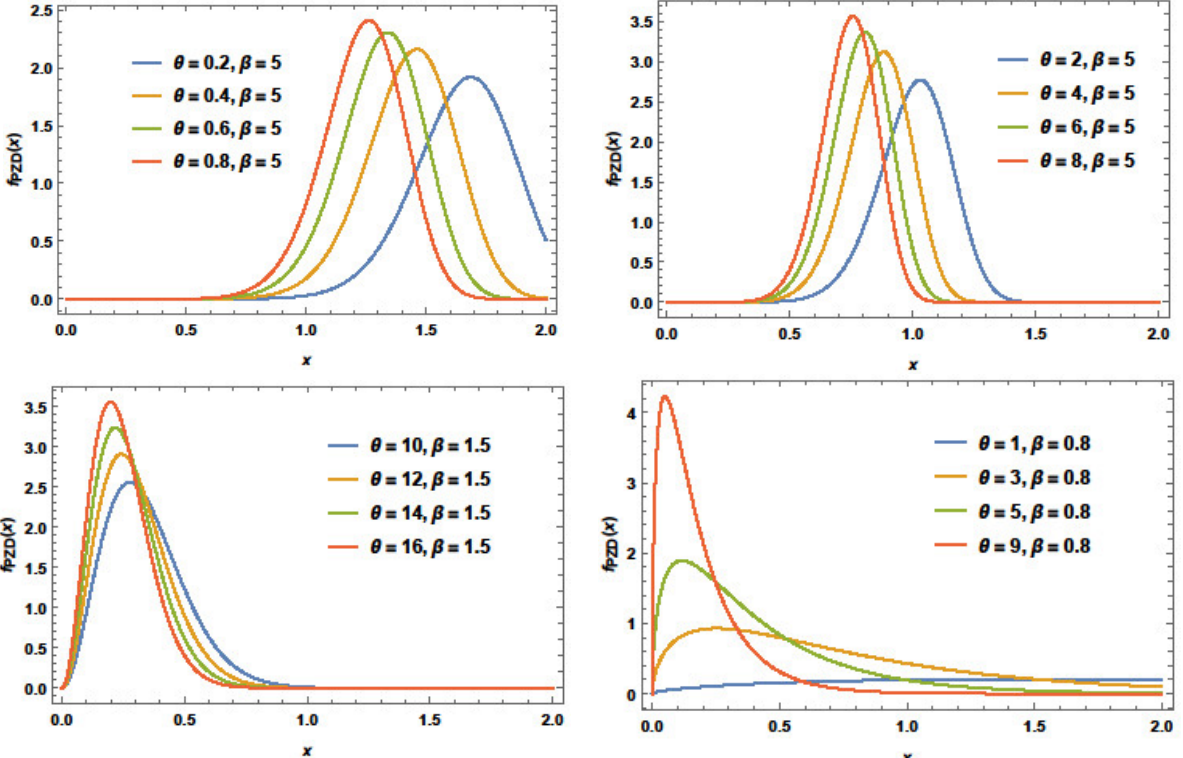
Figure 2. Plots of the cdf of PZD for selected values of  and  .